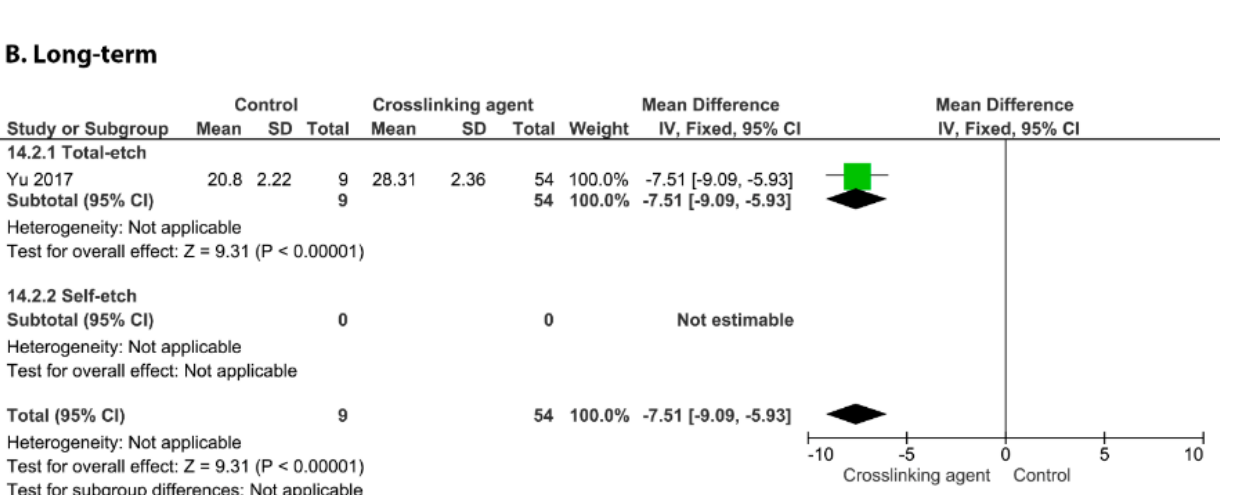
Figure 12. Forest plot of the immediate ( A ) and long-term ( B ) bond strength comparison between the EGCG crosslinking agent and the control according to the adhesive used, [84]. Conferring to the parameters contemplated in the risk of bias assessment, the majority of manuscripts were categorized with a medium risk of bias (Table 4). Numerous studies failed to report the single-operator, operator-blinded, and sample size calculation parameters.